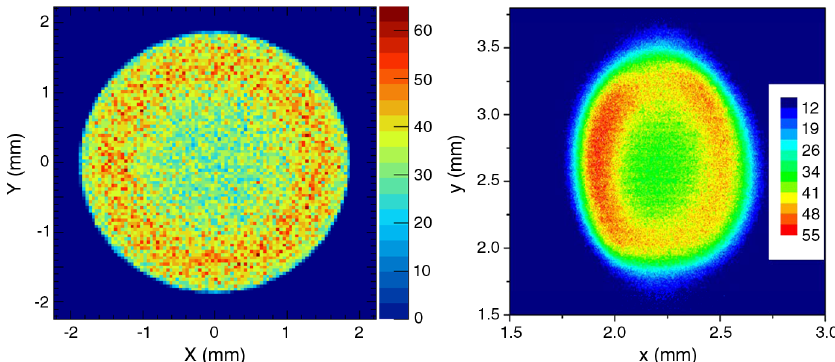
FIG. 10. Transverse beam profile simulated with OPAL (left) and measured on a fluorescent screen (right); 14 pC; 5.5 MeV; z ¼ ¼ 300 kV ; gap ¼ 6 mm ; ’ 2 : 6 m ; V pulser (100 mT in simulation).